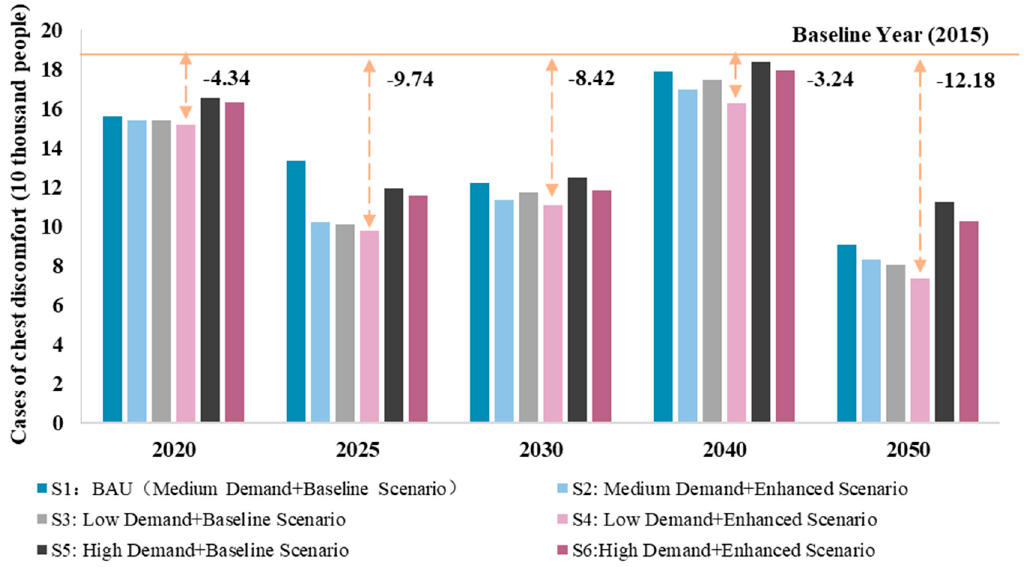
Figure 6. Health e ff ects of PM 2.5 emissions under di ff erent scenarios in the steel sector. Figure 6. Health effects of PM 2.5 emissions under different scenarios in the steel sector.